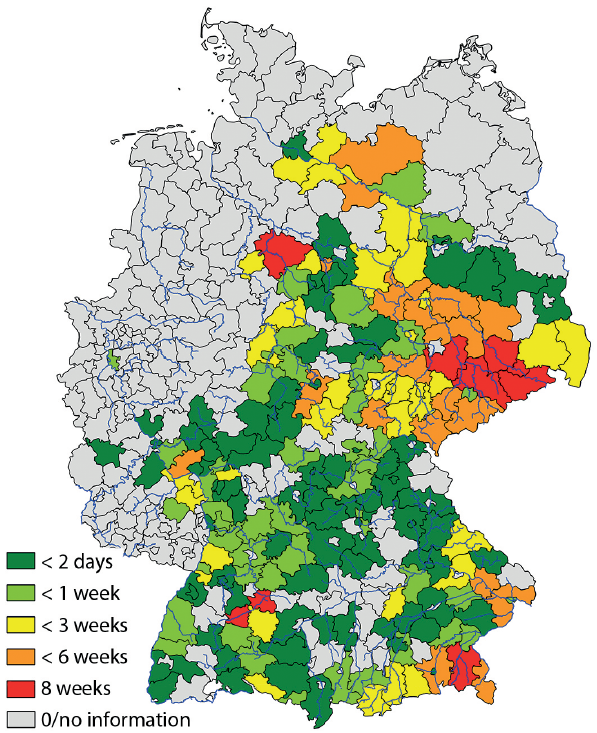
Figure 7. Overall duration of the obstructions in road traffic induced by the flood event shown in terms of administrative districts.